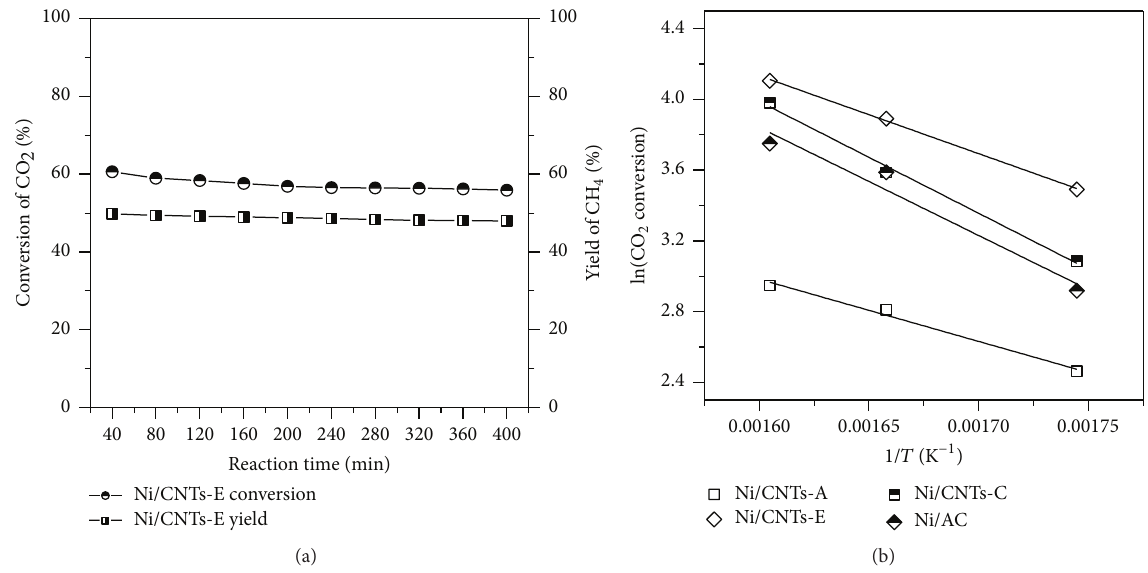
Figure 7: CO 2 conversion and CH 4 yield versus reaction time at 350 ∘ C (a) and logarithm of CO 2 conversion versus the reciprocal of temperature (b) on the